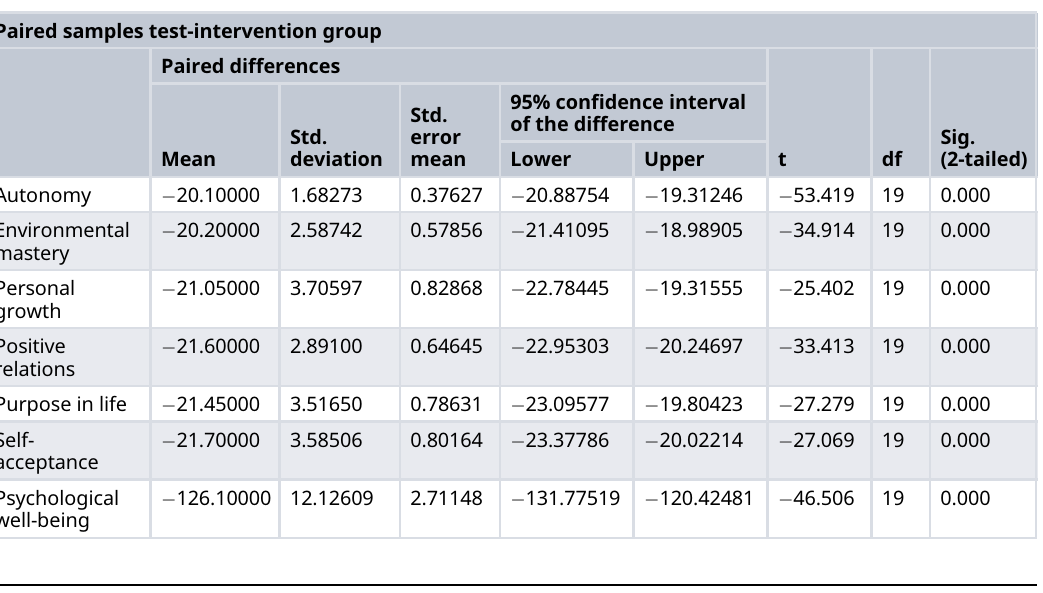
Table 4. Comparing pre and post intervention PWB measurements for the control group (CG). Paired samples test-control